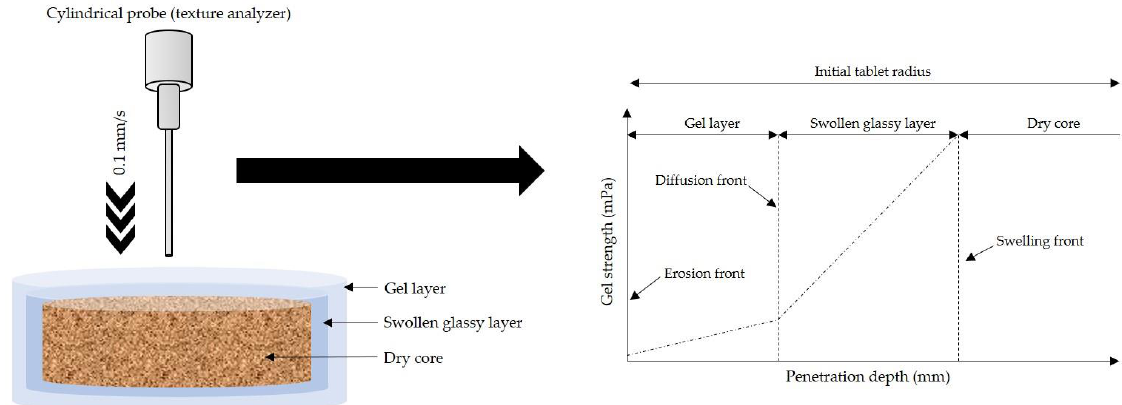
Figure 1. Schematic representation of gel strength determination upon hydration.